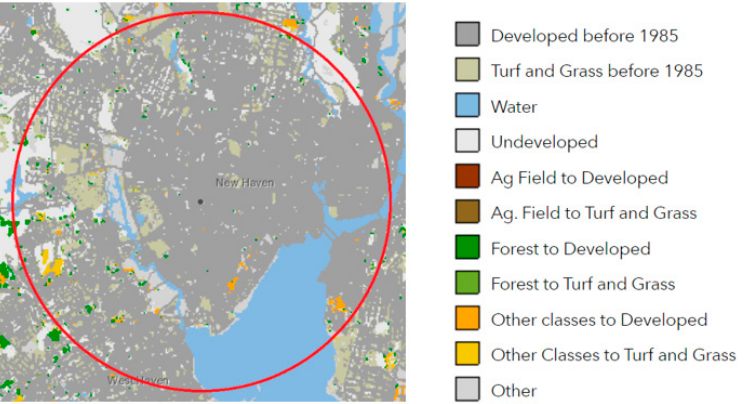
Figure 5. Land cover change 1985 to 2015 (UConn CLEAR).